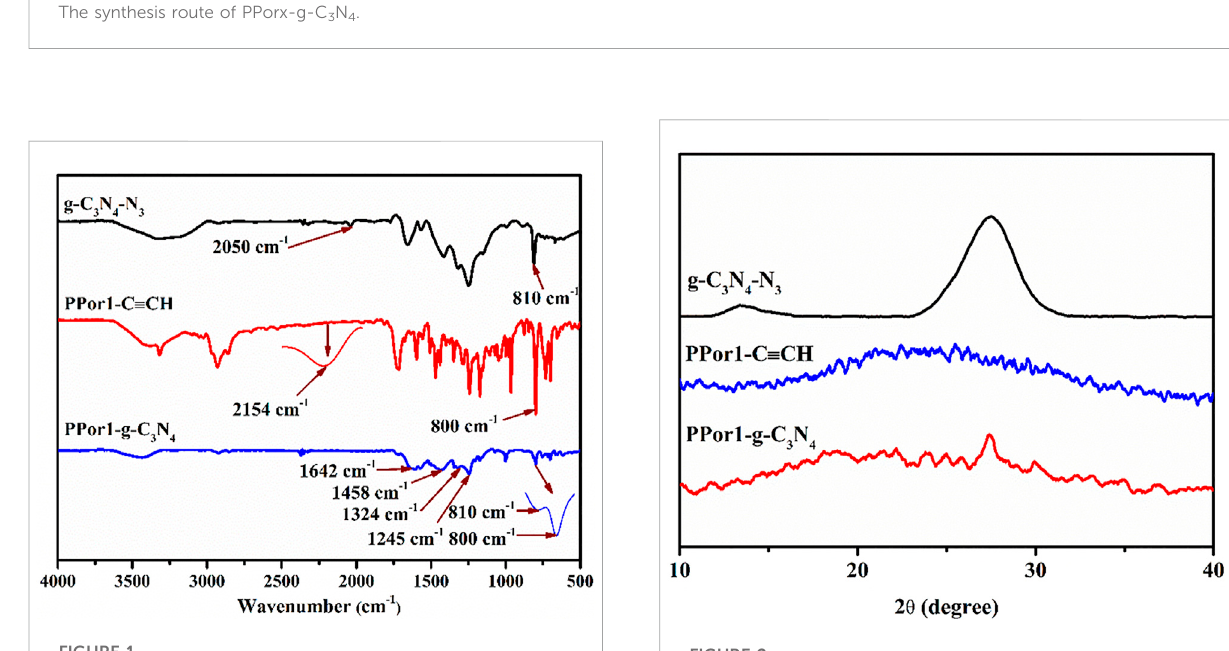
FIGURE 1 The FT-IR spectra of g-C 3 N 4 -N 3 , PPor1-C ≡ CH and PPor1-g- C 3 N 4 .